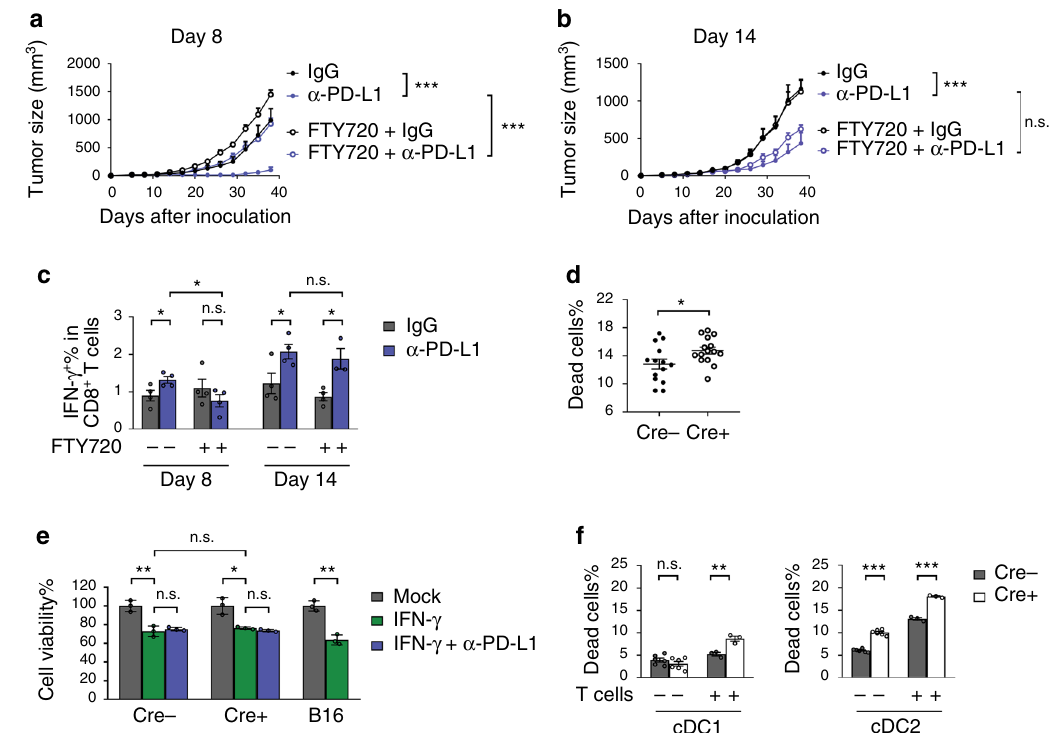
Fig. 5 PD-L1 blockade reactivates T cells in tumor microenvironment for tumor control. a , b C57BL/6 mice ( n = 6, except day 14 FTY720 + anti-PD-L1 n = 5) were inoculated with 2.5×10 5 MC38-OVA cells and treated with ( a ) 200 μ g IgG or anti-PD-L1 on days 8 and 12, or ( b ) 250 μ g IgG or anti-PD-L1 on days 14 and 18. Mice were also treated with control or FTY720 the same day as antibody treatment. Tumor growth curves were shown. *** p (8: IgG vs anti-PD-L1) < 0.0001; *** p (8: anti-PD-L1 vs FTY720 + anti-PD-L1) <0.0001; *** p (14: IgG vs anti-PD-L1) <0.0001. c Mice ( n = 4, except day 14 FTY720 + anti-PD-L1 n = 3) were treated as in 5a and 5b . IFN- γ + CD8 T cells in tumor tissues were measured by fl ow cytometry on day 13 (for day 8 treatment group) or on day 19 (for day 14 treatment group). * p (8: IgG vs anti-PD-L1) = 0.0462; * p (14: IgG vs anti-PD-L1) = 0.0443; * p (14: FTY720 + IgG vs FTY720 + anti-PD-L1) = 0.0119; * p (8: anti-PD-L1 vs FTY720 + anti-PD-L1) = 0.0245. d CD11c-cre; Pdl1 fl / fl or control mice ( n = 14 Cre − , 15 Cre + ) were inoculated with 5×10 5 MC38 cells. Viability of DCs was analyzed by fl ow cytometry on day 14. * p = 0.0322. e DCs puri fi ed from conditional knockout mice or B16 cells were treated with IFN- γ for 96h. Cell viability was determined by MTT assay ( n = 3 cells). ** p (Cre-) = 0.0048; * p = 0.0101; ** p (B16) = 0 . 0012. f DCs isolated from spleens of CD11c-cre; Pdl1 fl / fl or control mice were loaded with OT-1 peptide and incubated with activated OT-1 T cells at an E:T ratio of 3 for 4h. Cell death of cDC1 and cDC2 cells were measured by fl ow cytometry ( n = 6 -T cells, 3 + T cells). ** p = 0.0067; *** p (-T) <0.0001; *** p ( + T) <0.0001. Data are shown as mean + SEM ( a and b ) or mean±SEM ( c – f ) and are representative of